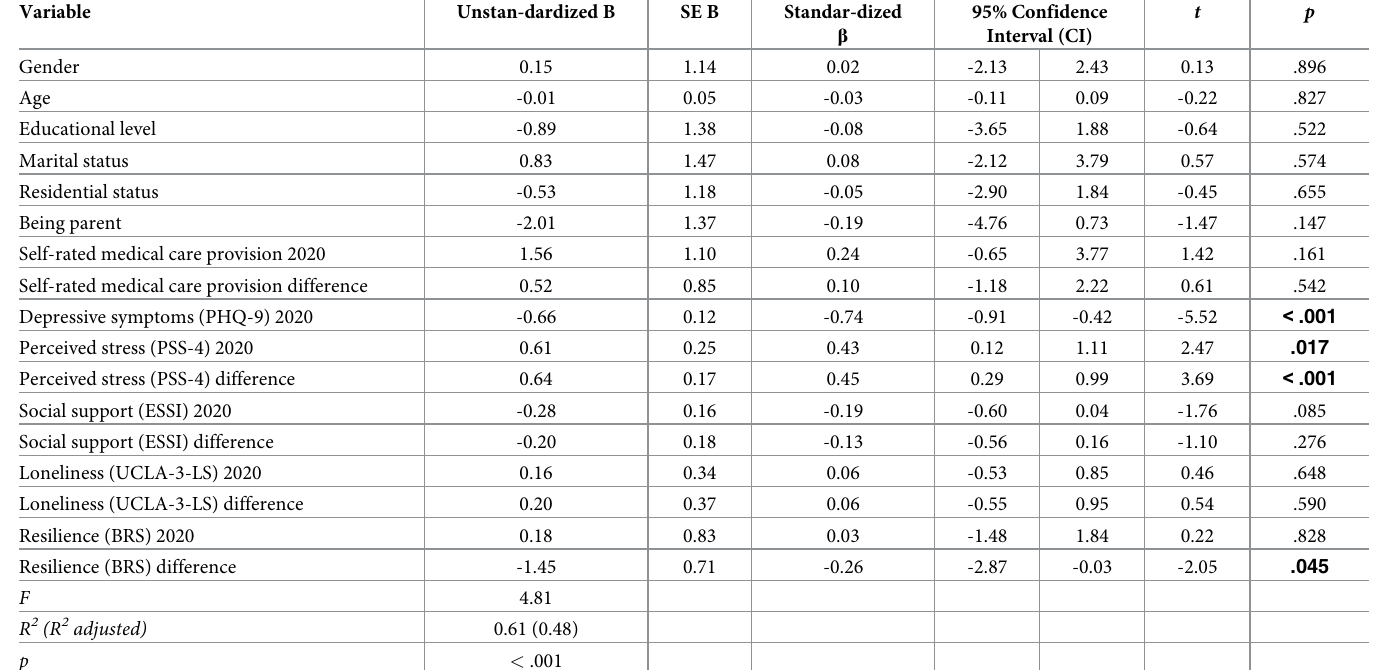
Table 3. Regression analysis on longitudinal changes in depressive symptoms ( n =